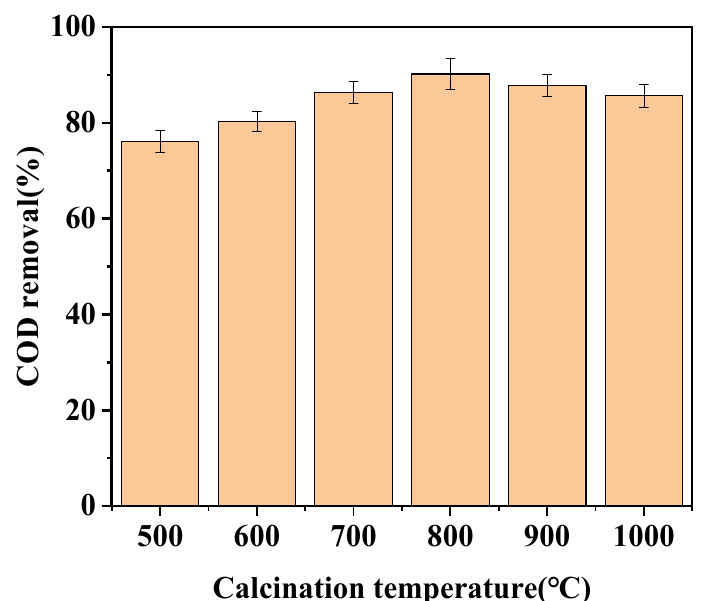
Figure 3. Effect of calcination temperature on catalytic effect. (Catalyst preparation conditions: catalyst support, CeO 2 , calcination time = 8 h; Reaction conditions: LaCoO 3 /CeO 2 = 0.8 g/L, H 2 O 2 = 40 mM, 120 °C, 1 MPa, 60 min).